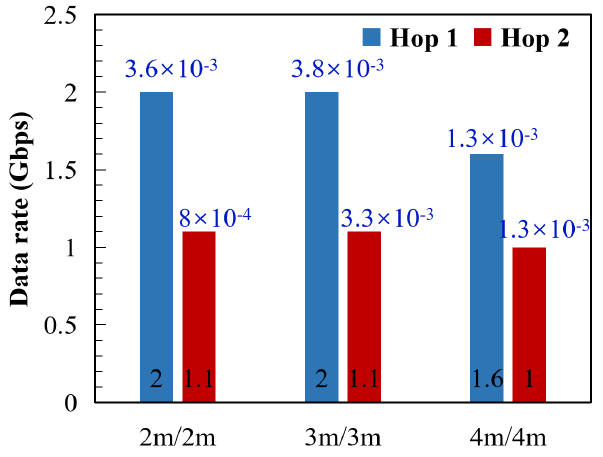
Figure 10. Measurement of maximum data rate within FEC limit at different lengths (The blue font on the histogram represents the BER for the corresponding case).